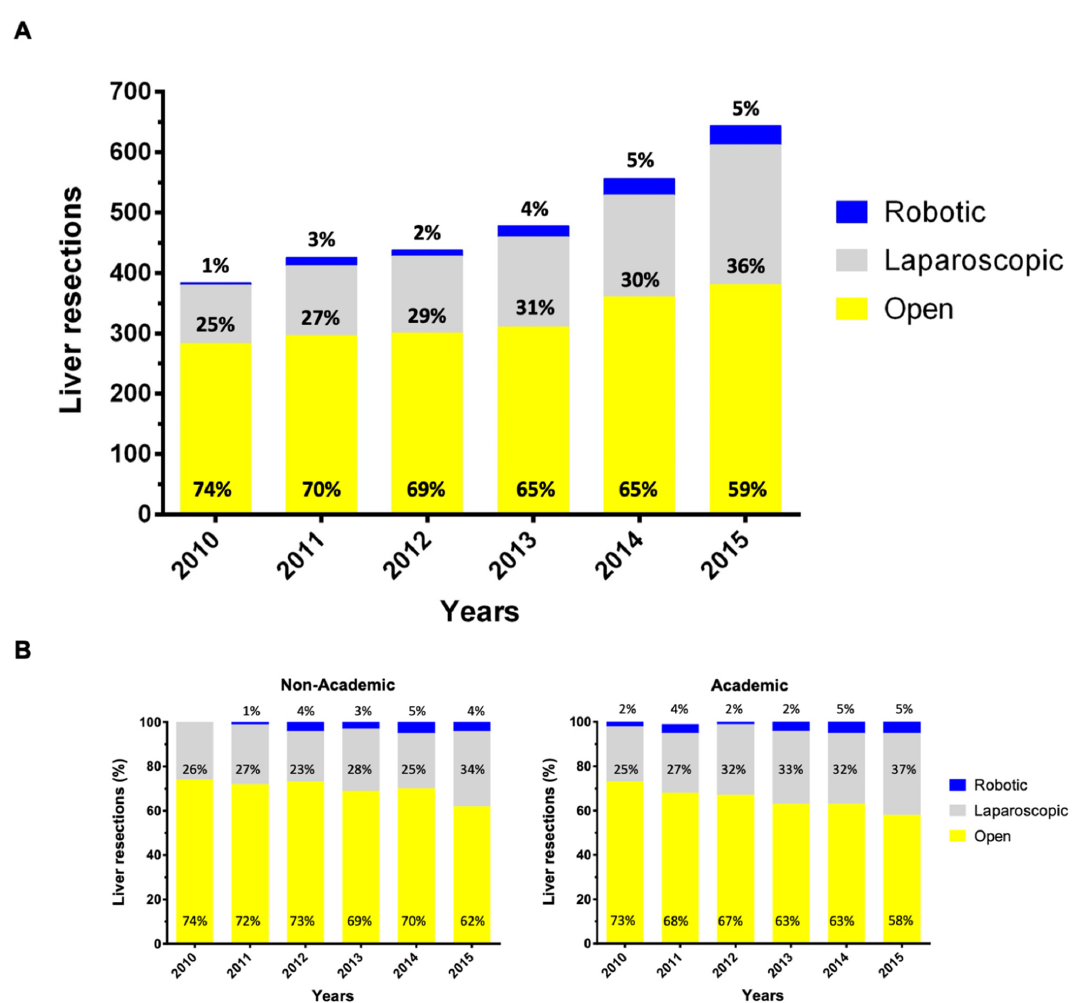
Figure 2. Trends of minimally invasive liver resection utilization for stage I/II HCC treatment. Use of minimally invasive surgery (laparoscopic and robotic) versus open hepatectomy for stage I or II hepatocellular carcinoma over time in the unmatched study population from the National Cancer Center Database 2010-2015 ( A ) and stratified by the facility type ( B ). Patients’ clinicopathological characteristics are summarized in Table 1. In the un- matched cohort, patients in the MILR group were more frequently treated at an academic institution ( p = 0.015) and at an East North Central region ( p < 0.001) and less frequently underwent an (extended) lobectomy ( p < 0.001). After propensity score matching, both groups were well balanced for all baseline/clinicopathologic covariates, including the type of surgical procedure (Figure S1).